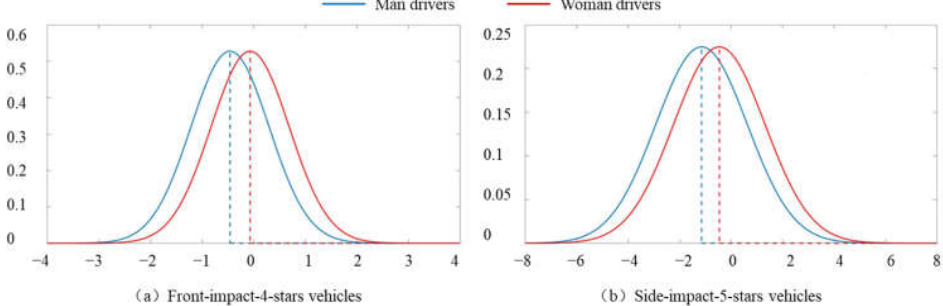
Figure 2. Random distribution of the parameter different 5-star ratings of vehicles.